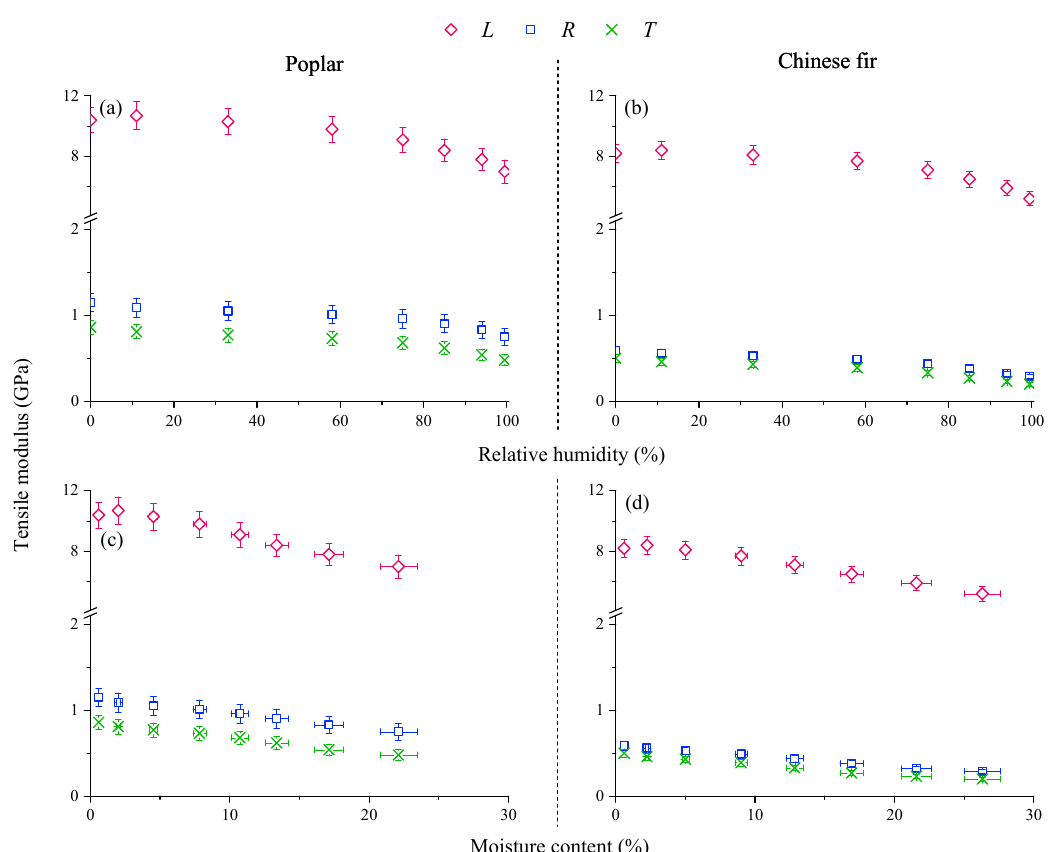
Figure 2. Influence of relative humidity on tensile modulus of poplar ( a ) and Chinese fir ( b ) and moisture dependence relations ( c and d ).